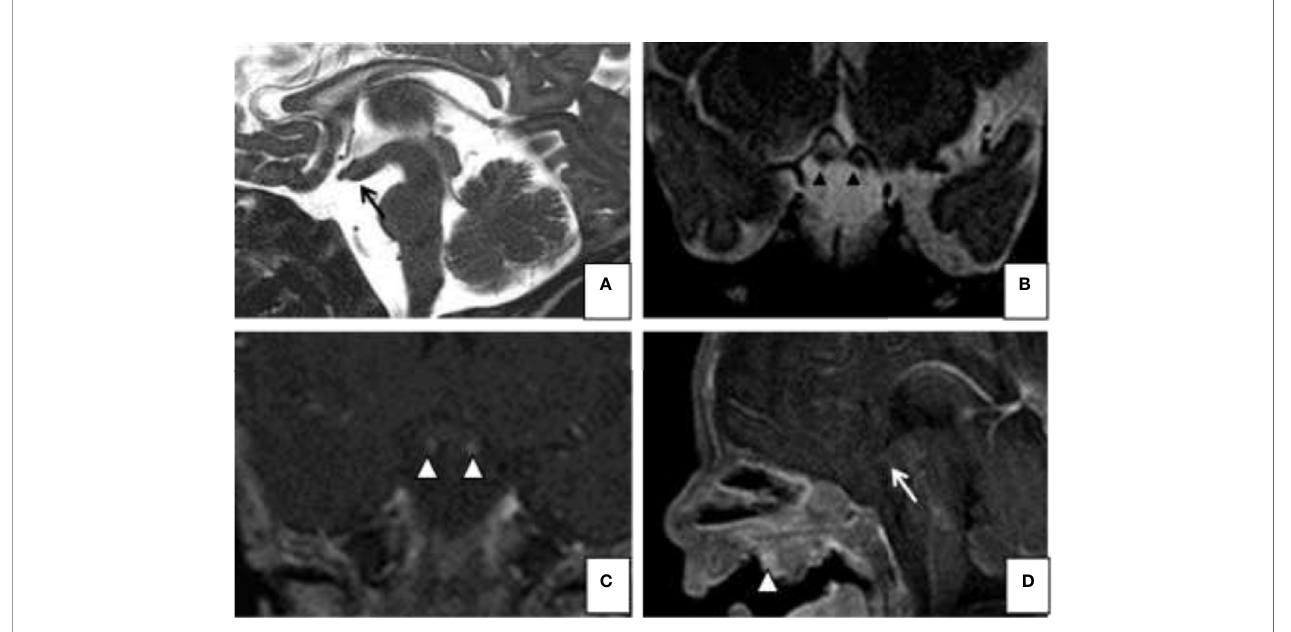
FIGURE 1 | Magnetic resonance imaging (MRI). Sagittal (A) and coronal (B) T2-weighted images; Gd-enhanced coronal (C) T1- weighted and sagital (D) T1-images show on the midline sagittal plane, a thickened third ventricle fl oor (arrow a and d), tubomamillary fusion and the absence of a midline sella turcica and pituitary infundibulum. Coronal T2 and T1 WI MR (C) reveal 2 pituitary stalks (arrowheads b and c). The MRI also demonstrates a midline nasopharyngeal teratoma (arrowhead D